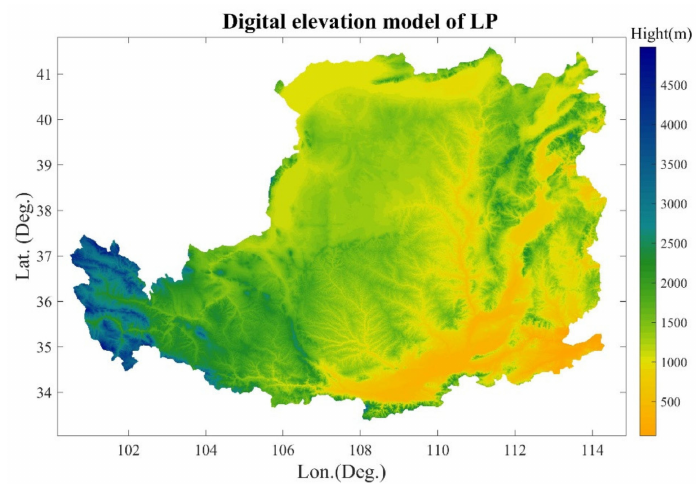
Figure 4. Elevation distribution of the Loess Plateau region.